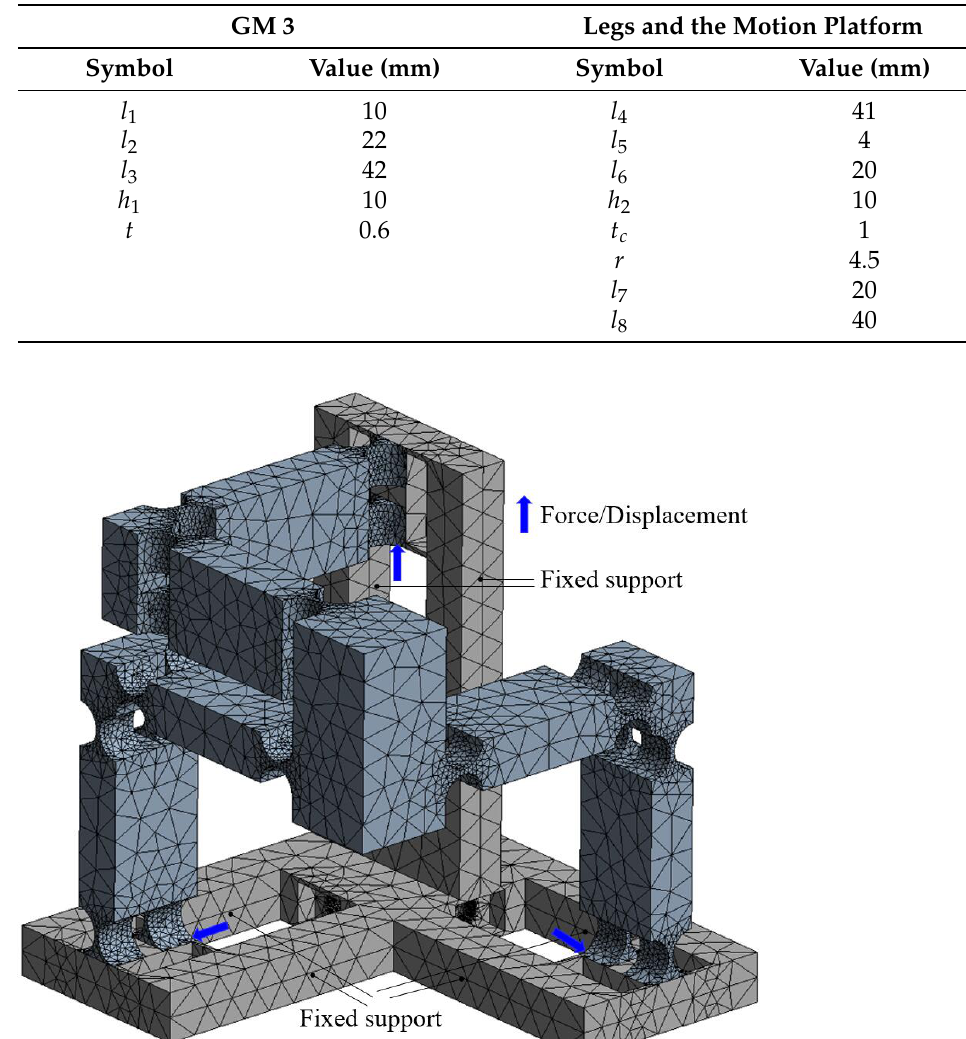
Table 1. Dimensional parameters of the proposed triaxial compliant manipulator.